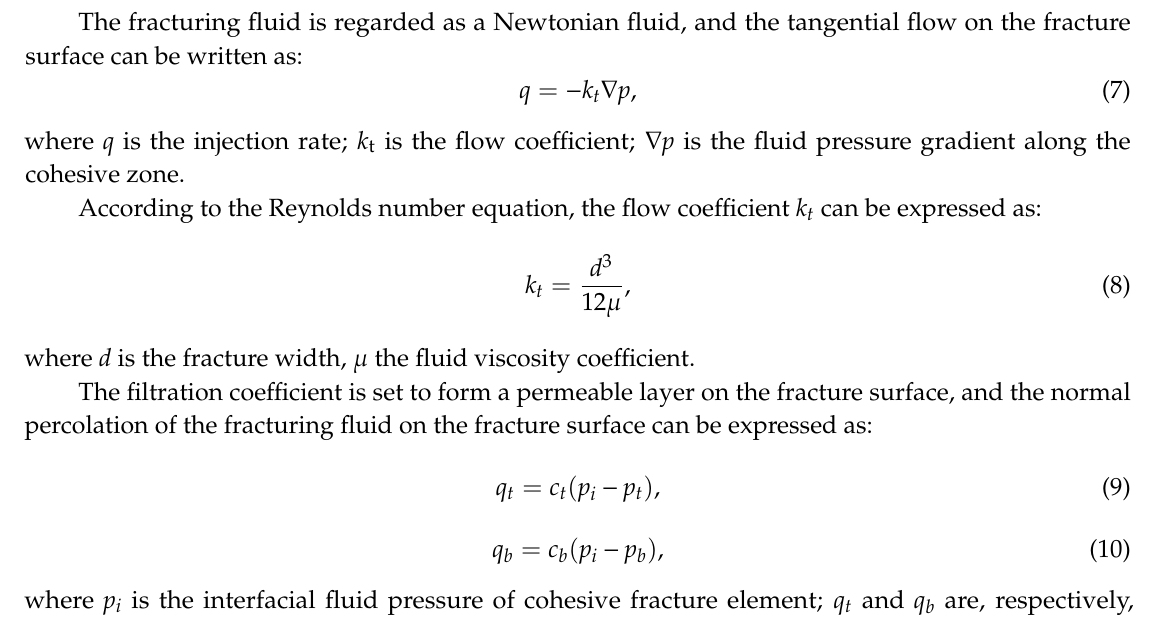
Figure 2. Schematic of fluid flow at the fracture tip. The cohesive zone in a hydraulic fracture is classified into a broken cohesive zone and unbroken cohesive zone. The flow of the fluid within the cohesive element includes tangential flow and normal flow.